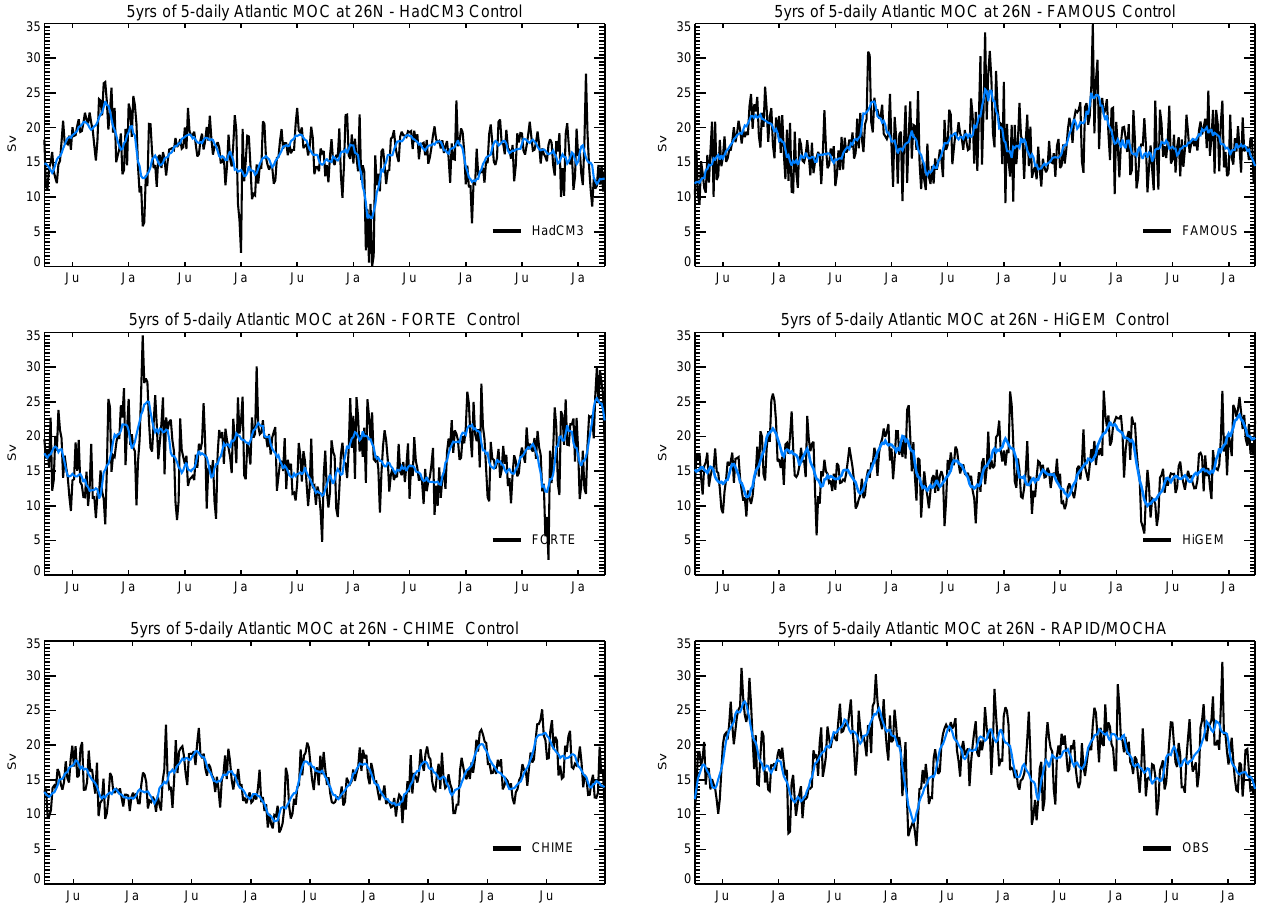
Fig. 2. 5-yr timeseries of 5-daily Atlantic MOC ( T over ) at 26 ◦ N in observations and in the RAPID-AOGCMs. (Data with a 45-day moving average is shown in blue.) Other RAPID-models, GENIE and FRUGAL with simple atmospheric components, have little interannual variability. The last 5yr of the 10yr of data from each AOGCM is shown here.